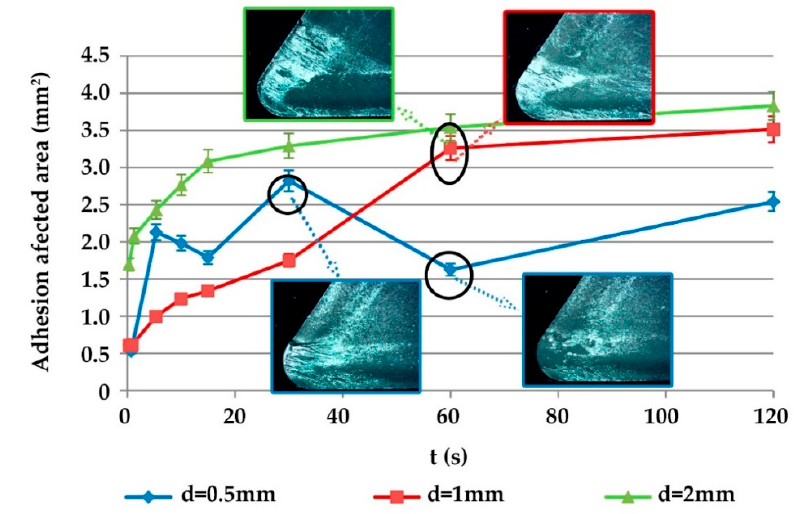
Figure 5. Secondary adhesion affected area as a function of cutting time.